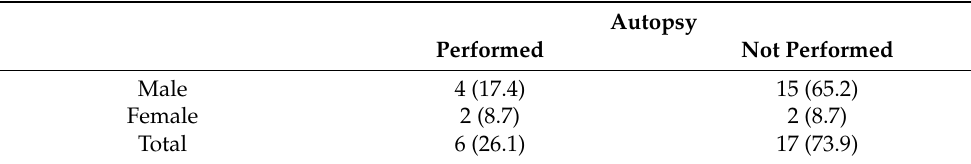
Table 6. The table shows the total number of cases in which an autopsy was performed. The percentage was calculated based on the total number of dead subjects [23].